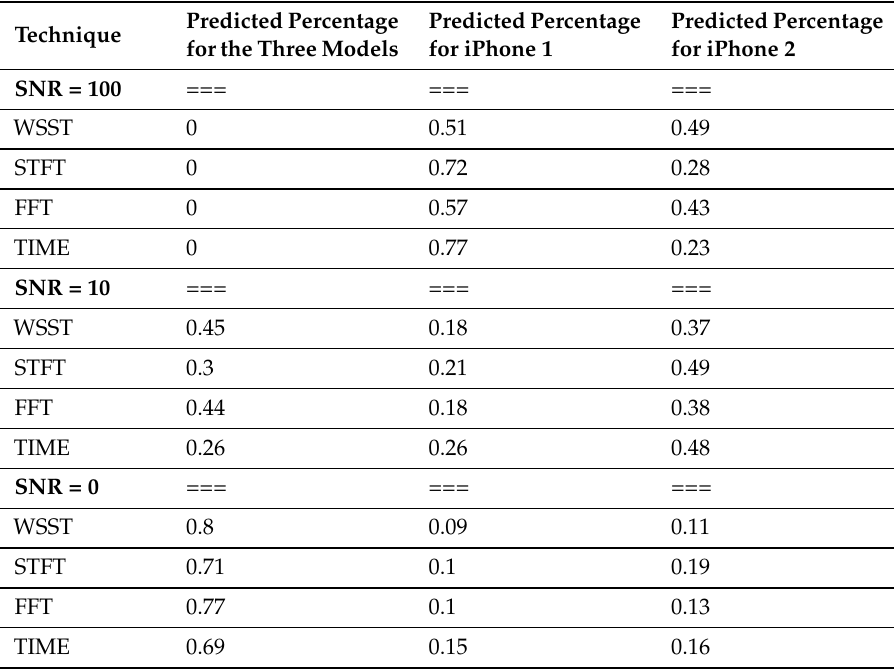
Table 3. Predicted percentage with an unknown